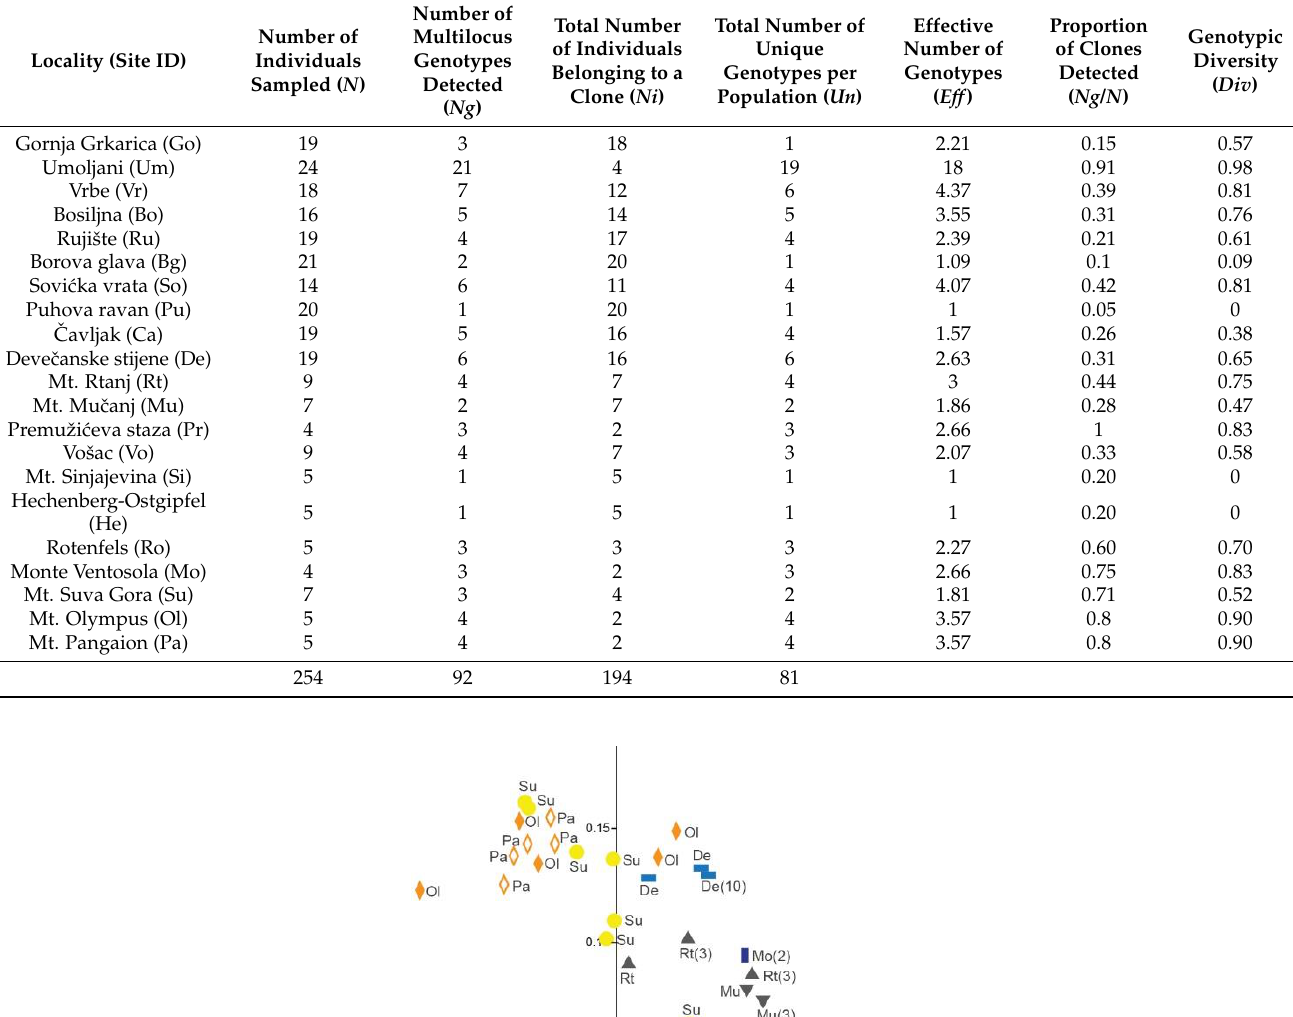
Table 4. Genetic diversity measures for the analyzed Cotoneaster integerrimus populations derived from nuclear microsatellites.